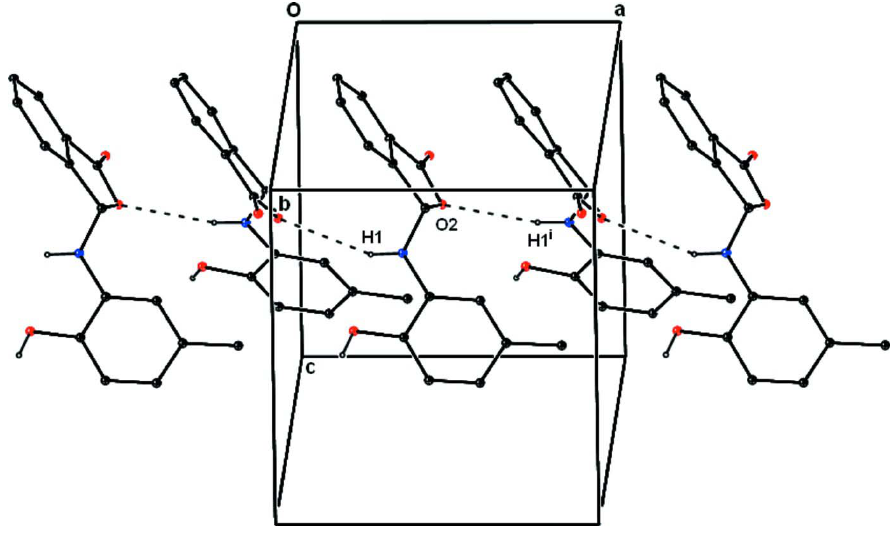
Figure 2 A partial packing diagram of (I), showing the formation of C(4) chain along the [100] direction. Hydrogen bonds are shown as dashed lines [symmetry code: (i) 1 - x, -y, z + 1/2]. H atoms not involved in hydrogen bondings have been omitted for